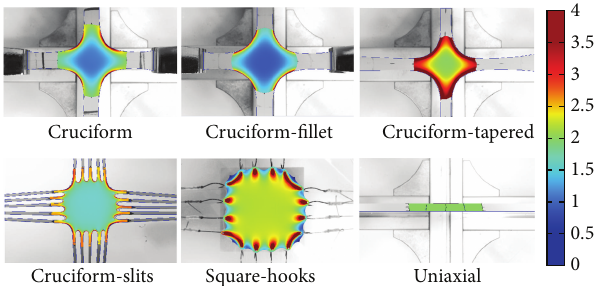
Figure 7: Contour maps of von Mises stress (MPa) superimposed on real deformed shapes of the specimens.